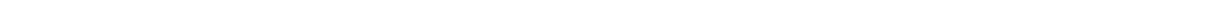
Fig. 6 Signaling responsiveness of transitional and mature B cell subsets from CH103 germ line knock-in mice. a Representative fl ow histograms showing selectively reduced IgM mean fl uorescence intensity (MFI), in differential-binding transmitted-founder (TF) Envelope (Env + ) mature B cell fractions in CH103 unmutated common ancestor (UCA) double knock-in (dKI) mice, relative to Env − (light-chain (LC)-edited) fractions. Data show gating for Env- speci fi c bone marrow (BM) and splenic Env + and Env − trans or mat B cell fractions, and is gated on live, total (B220 + ) B cells or live, total splenocytes, respectively. b Graphical summary (means + SEM) of data shown in ( a ) performed on eight mice per strain. c Ex vivo proximal signaling responses to BCR cross-linking in naive B cells from CH103 UCA dKI and control B6 mice, based on Ca ++ levels (Fluo-4 MFI) before/after anti-IgM stimulation. Shown are representative data (from a single CH013 UCA dKI mouse) of Ca ++ responses, to varying concentrations of anti-BCR, in mature B cells, either recirculating in BM (upper row) or in spleen follicles (lower row). Also shown for comparison is proximal signaling of mature B cells from control WT B6 mice. d Graphic representation of Ca ++ -signaling responses (means ± SD) in both transitional and mature (splenic or BM B cells). Data are cumulative from four mice and two independently performed experiments. e CH103 UCA dKI transitional and mature B cell subset responses to priming immunogen TF Env. Data shown are from experiments performed in BM B cell fractions, using saturating amounts (100 nM) of tetramerized TF Env gp120 or anti-BCR (as a positive control for 100% of B cells signaling). * P < 0.05; ** P < 0.005, *** P < 0.001; two-tailed Student ’ s t- test. n.s. not signi fi